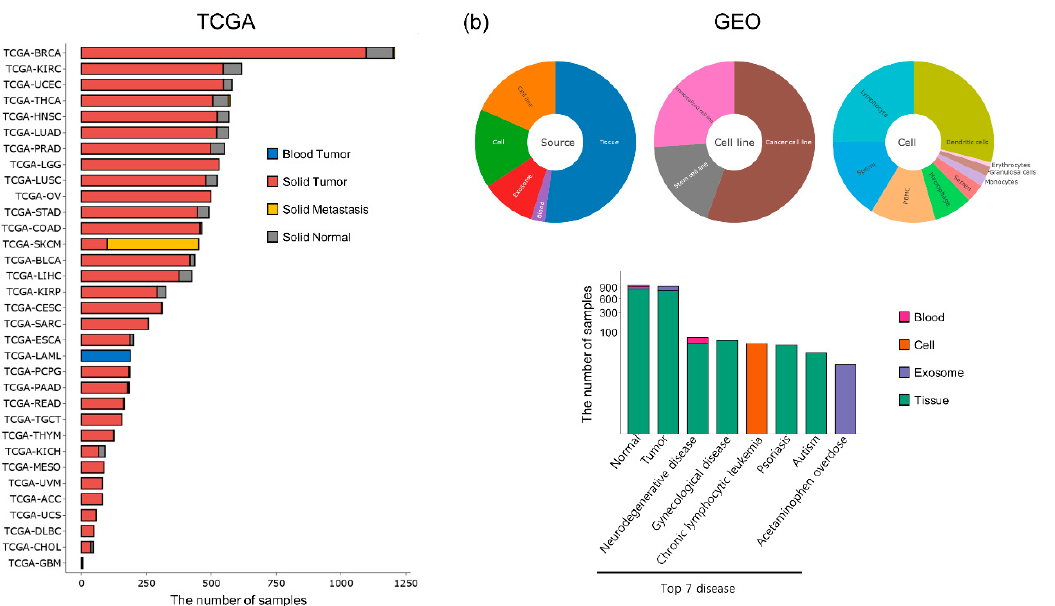
Figure 2. Summary of the data statistics in DBtRend. ( a ) The number of samples in different TCGA cancer types. ( b ) The numbers of samples in different source and top 7 disease from GEO datasets.